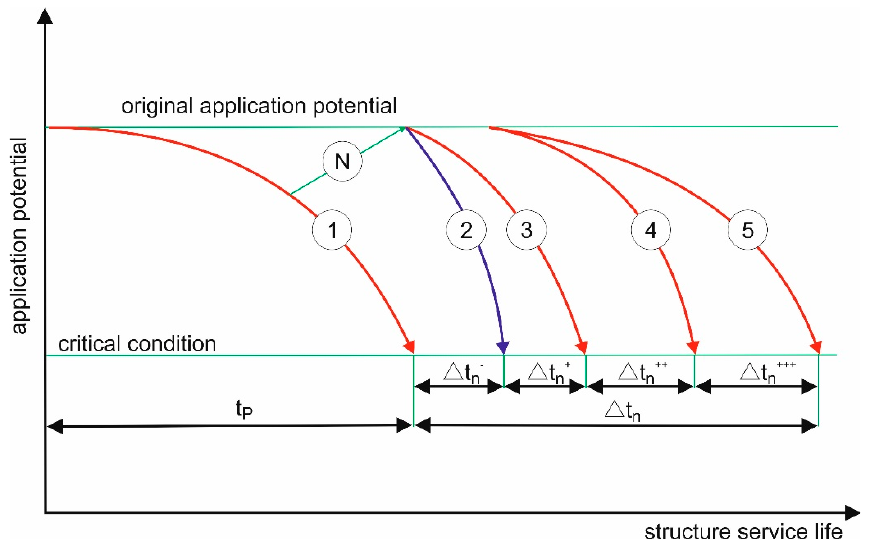
Figure 5. Schematic presentation of a repair cycle resulting in restoring the use potential: N—repair restoring the original use potential; 1—change in the use potential according to the design model; 2—change in the use potential after the repair, increased degradation rate as a result of new degradation sources triggered by the repair, e.g., electrochemical corrosion; 3—change in the use potential after the repair, unchanged degradation rate; 4—change in the use potential after the repair, degradation rate reduced e.g., as a result of lagging replacement; 5—change in the use potential after the repair, degradation rate additionally reduced by applying a surface protecting coating; tp—designed service life; ∆ t n- —additional service life gained owing to successful repair, reduced as a result of new degradation sources introduced by the repair; ∆ t n + —additional service life gained owing to successful repair, degradation rate unchanged; ∆ t n ++ —additional service life gained owing to successful repair, degradation rate reduced e.g., as a result of lagging replacement; ∆ t n +++ —additional service life gained owing to successful repair, degradation rate additionally reduced by applying a surface protecting coating.